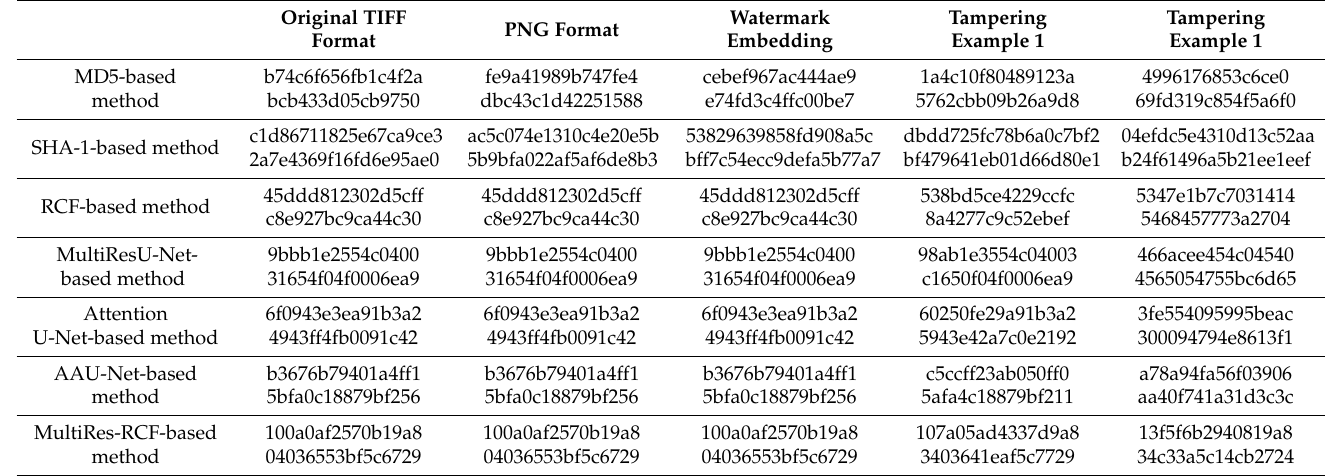
Table 2. Hash sequences obtained by different hash algorithms.